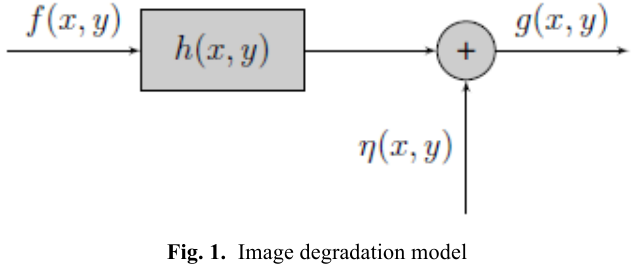
Fig. 1. Image degradation